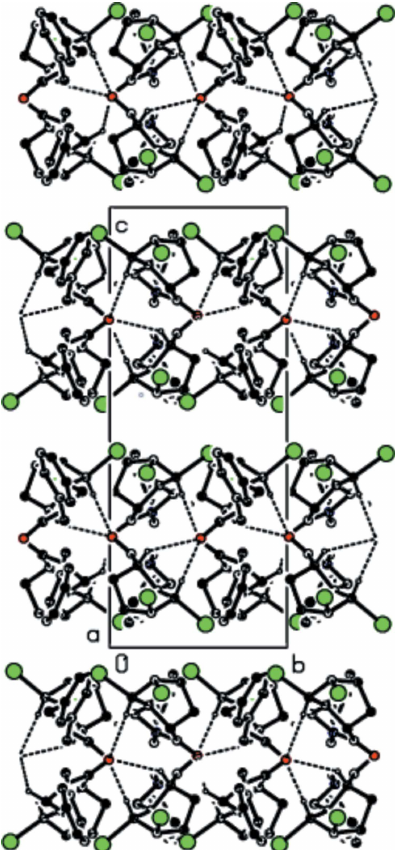
Figure 4 A view along the a axis of the intermolecular C—H (cid:2)(cid:2)(cid:2) O interactions in the title compound.